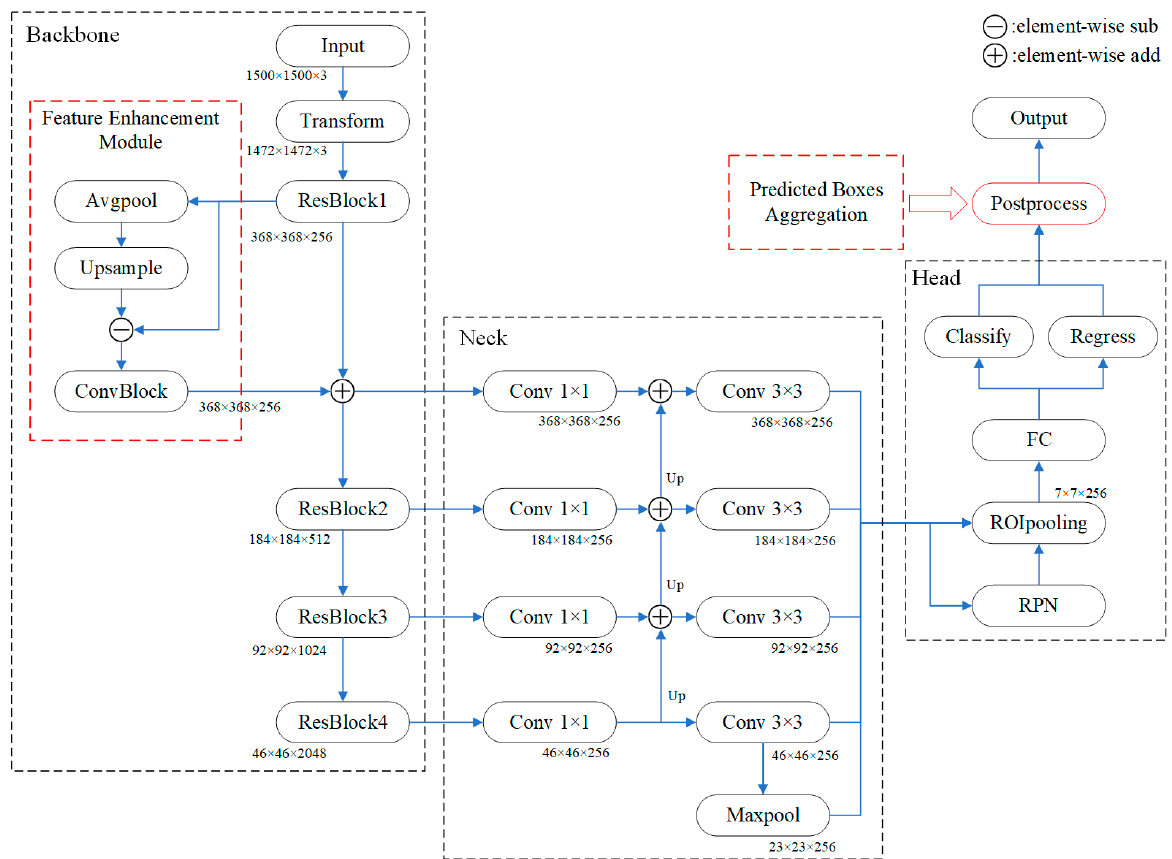
Figure 2. Improved Faster RCNN network framework.